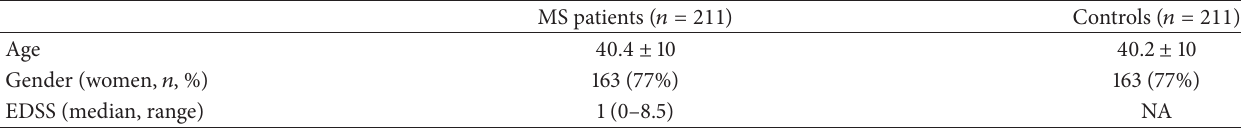
Table 1: Demographic and clinical features of MS patients and controls.